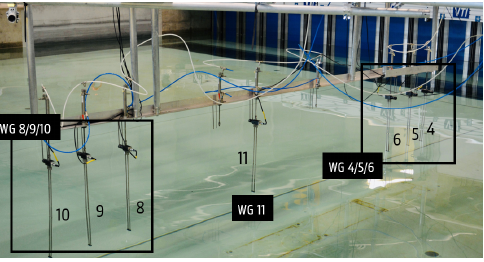
Figure 14. Picture of WGs layout for η measurements with WG 11 on the location of the WEC buoy. Three JONSWAP spectra and one regular wave are tested, defined in Table 6. Table 6. Overview of η measurement tests with WG11 on the location of the WEC buoy.